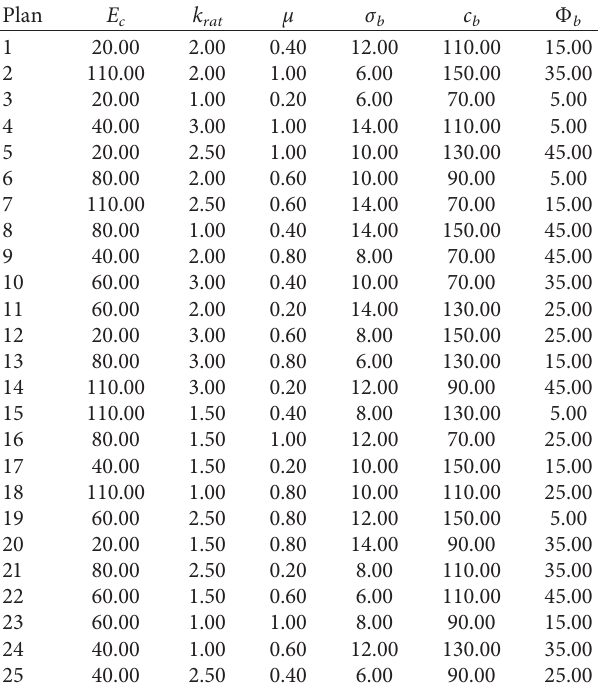
Table 12: Microparameters of orthogonal